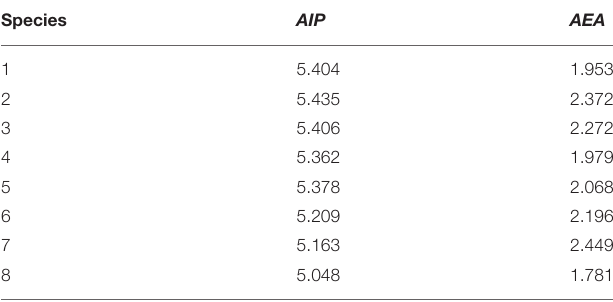
TABLE 4 | Calculated molecular AIP and AEA (both in eV) of 1 – 8 at the PBE0/6-31G(d,p) level. Species